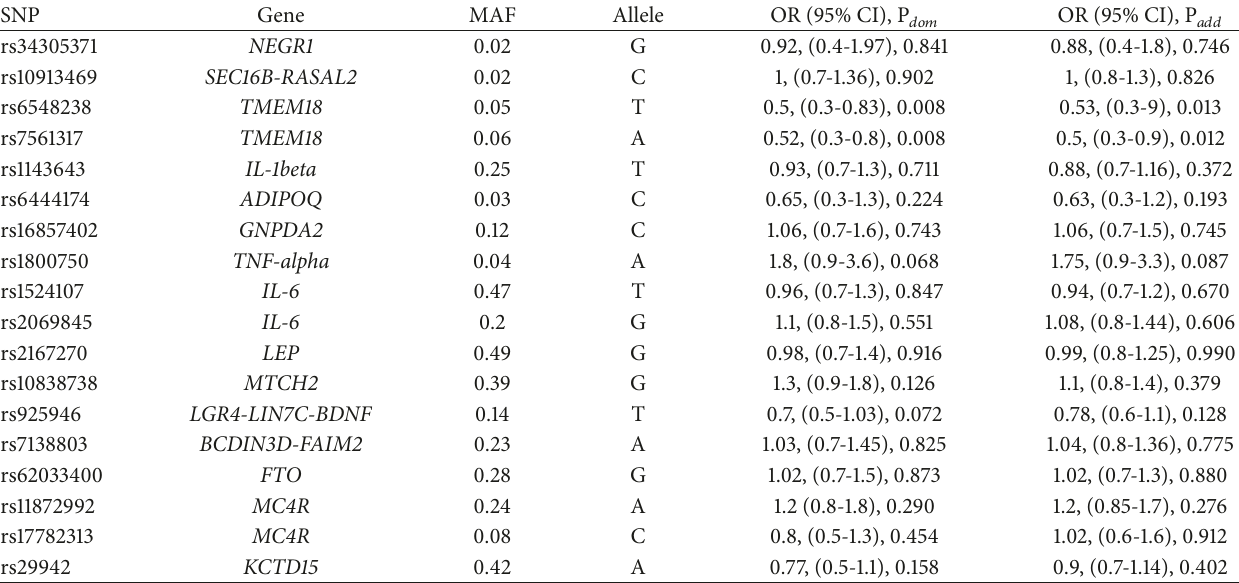
Table 3: Logistic regression of polymorphisms